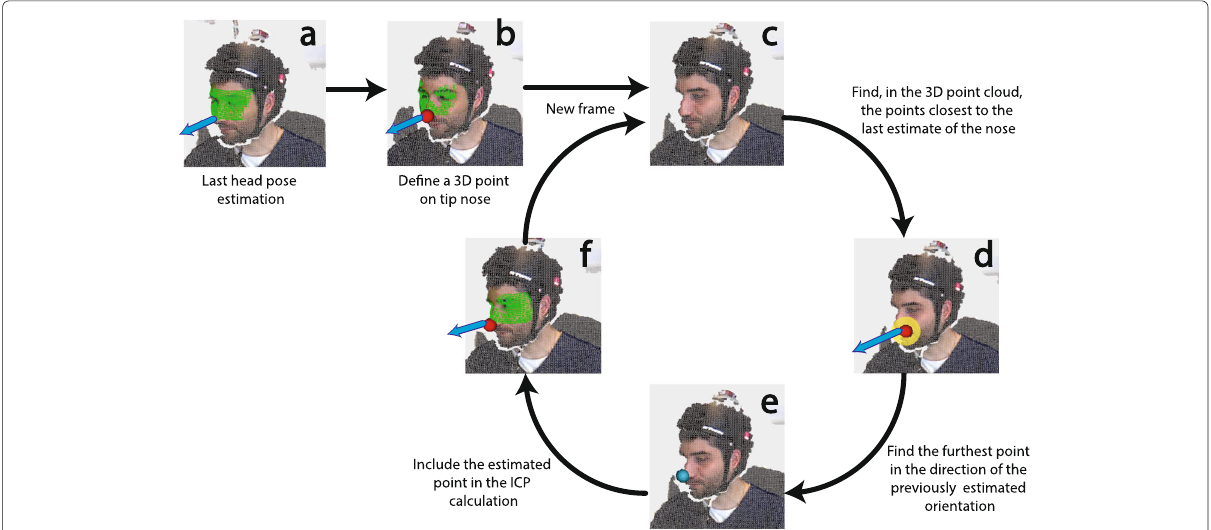
Fig. 2 Estimation of nose feature. From a previous pose ( a ), we define a 3D point on the tip of the nose ( b ). Then, From a new frame ( c ), we find all neighboring points from last estimation ( d ) and select the furthest point in the direction of last pose estimation ( e ). This point is then included in the ICP